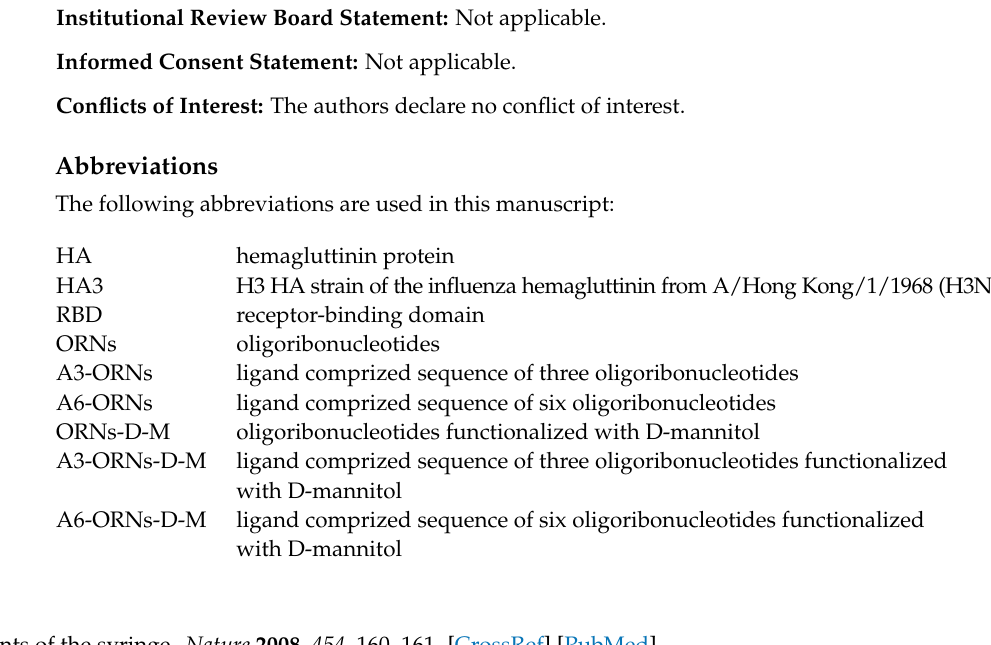
Yasara software. Table S1: Binding energies and dissociation constants evaluated for the complexes with of HA3 proten with A3-ORNs and A3-ORNs-D-M in obtained by docking procedures by the Yasara software. Table S2: Binding energies and dissociation constants evaluated for the complexes with of HA3 proten with A6-ORNs and A6-ORNs-D-M in obtained by docking procedures by the Yasara